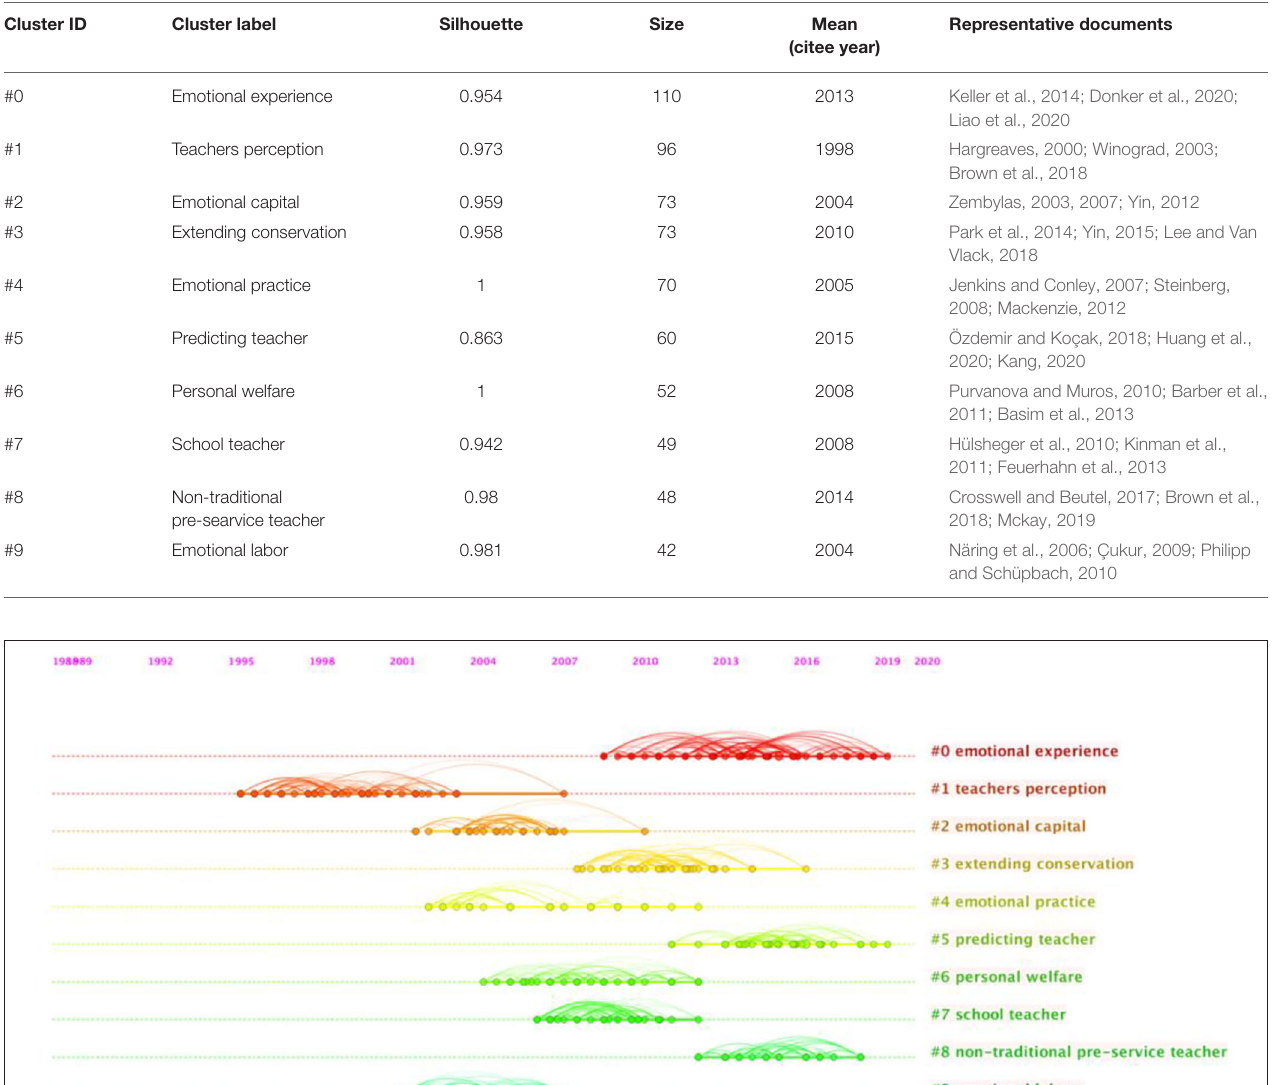
TABLE 7 | Specific information on the 10 major clusters.